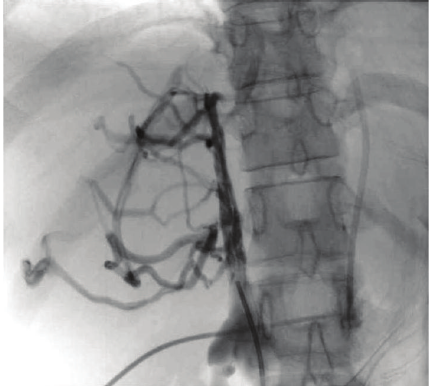
Figure 28: Spider web pattern of collaterals in BCS on catheter angiography.